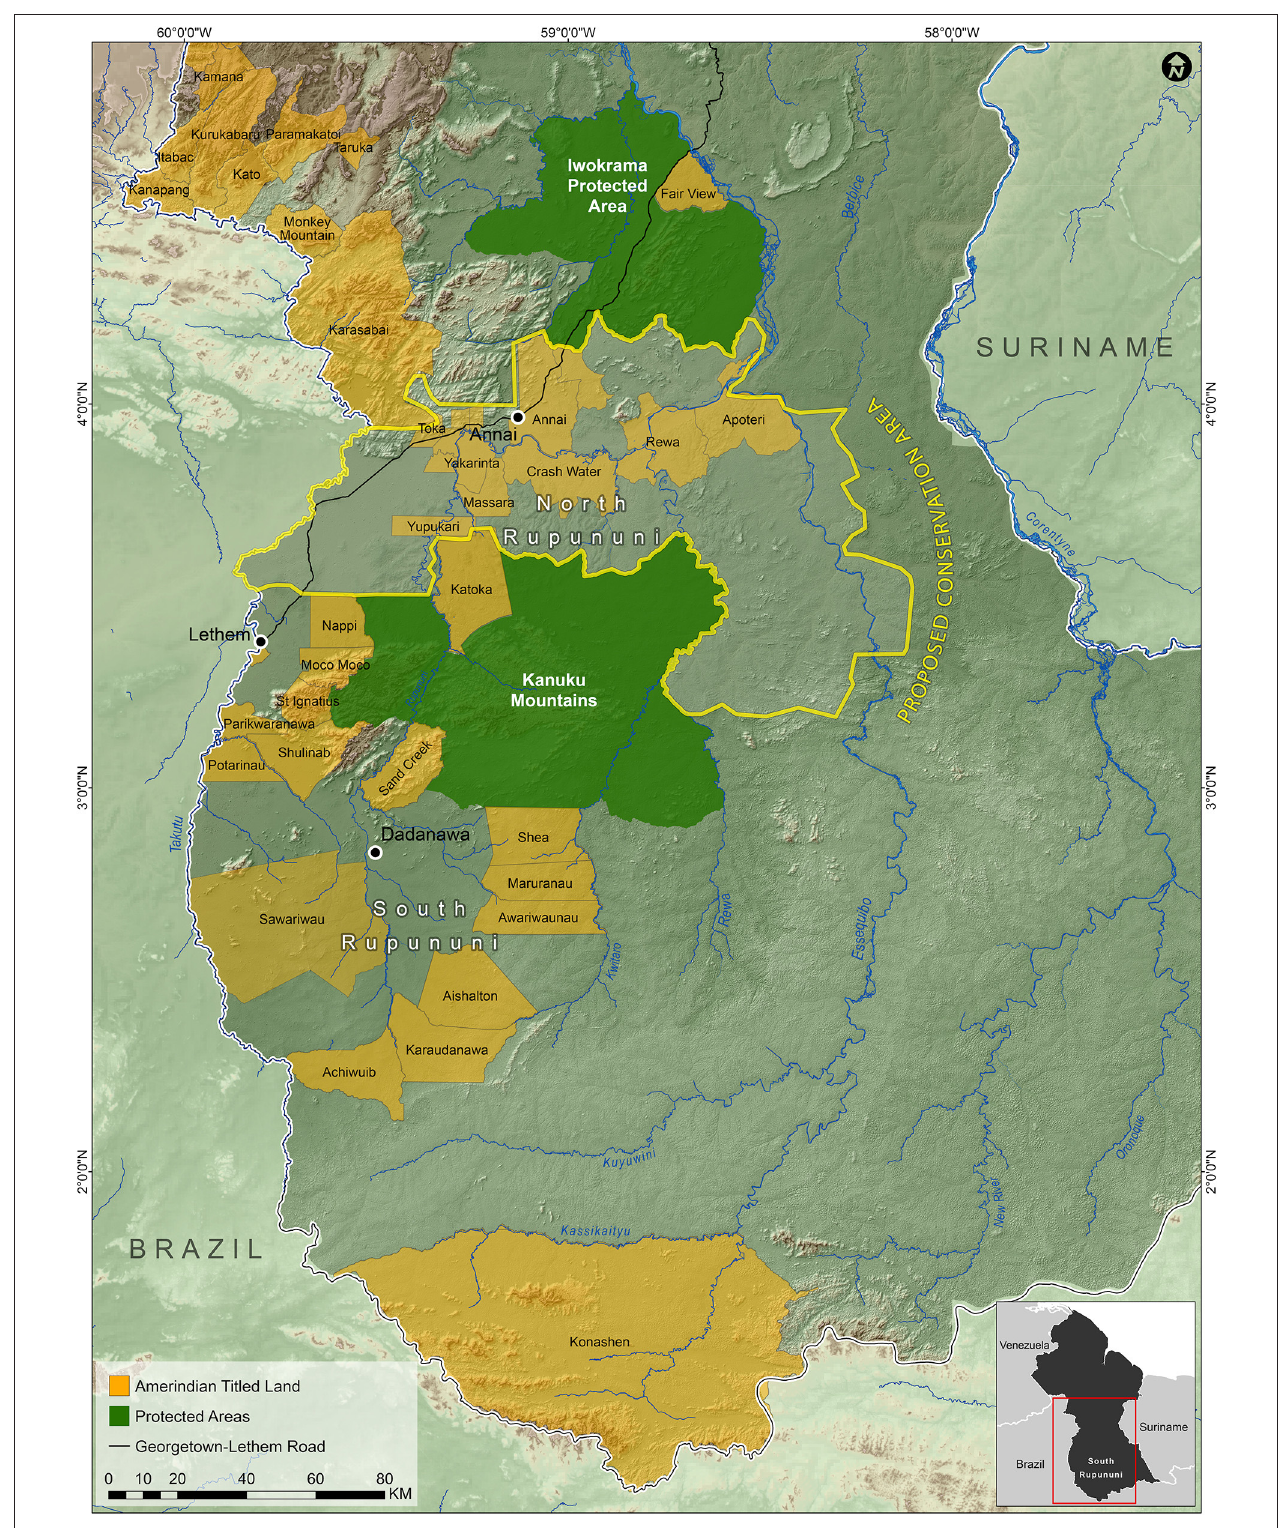
FIGURE 8 | Map of the suggested North Rupununi Conservation Area outlined in yellow which includes the Rupununi Portal and the ecological gradient of forests, savannas and wetlands.